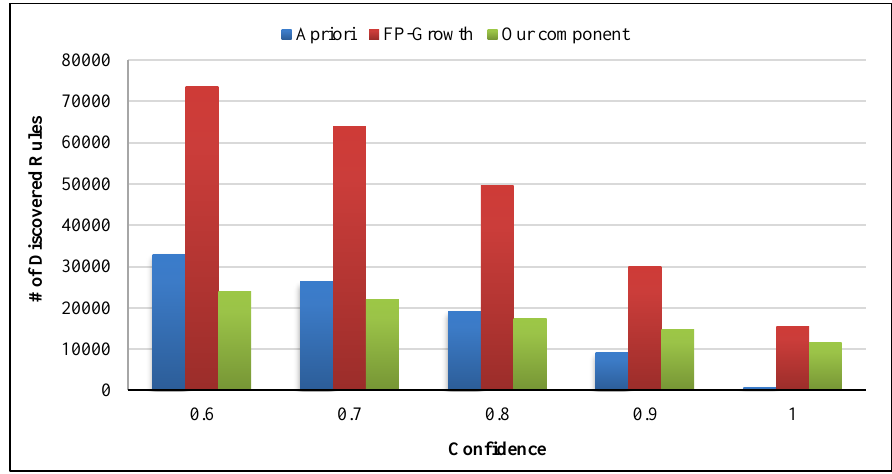
Figure 14. Rule number comparison for Adult data